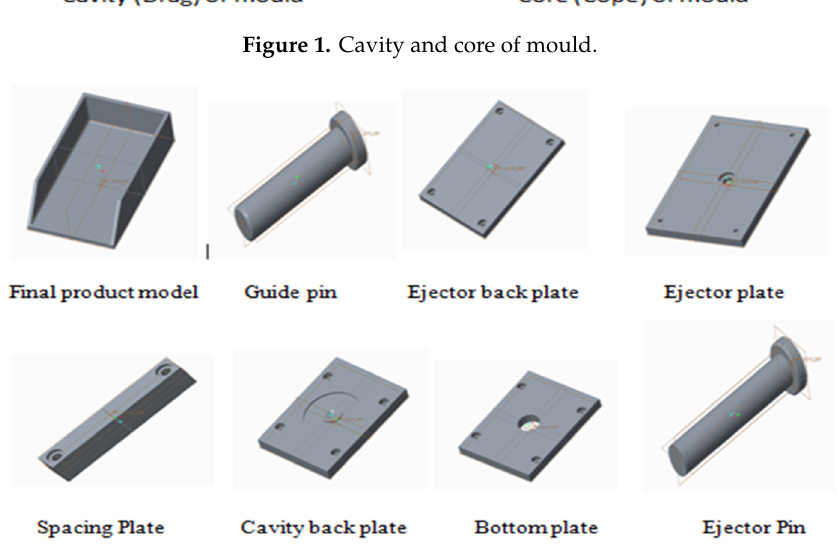
Figure 2. Models of different parts of a mould.